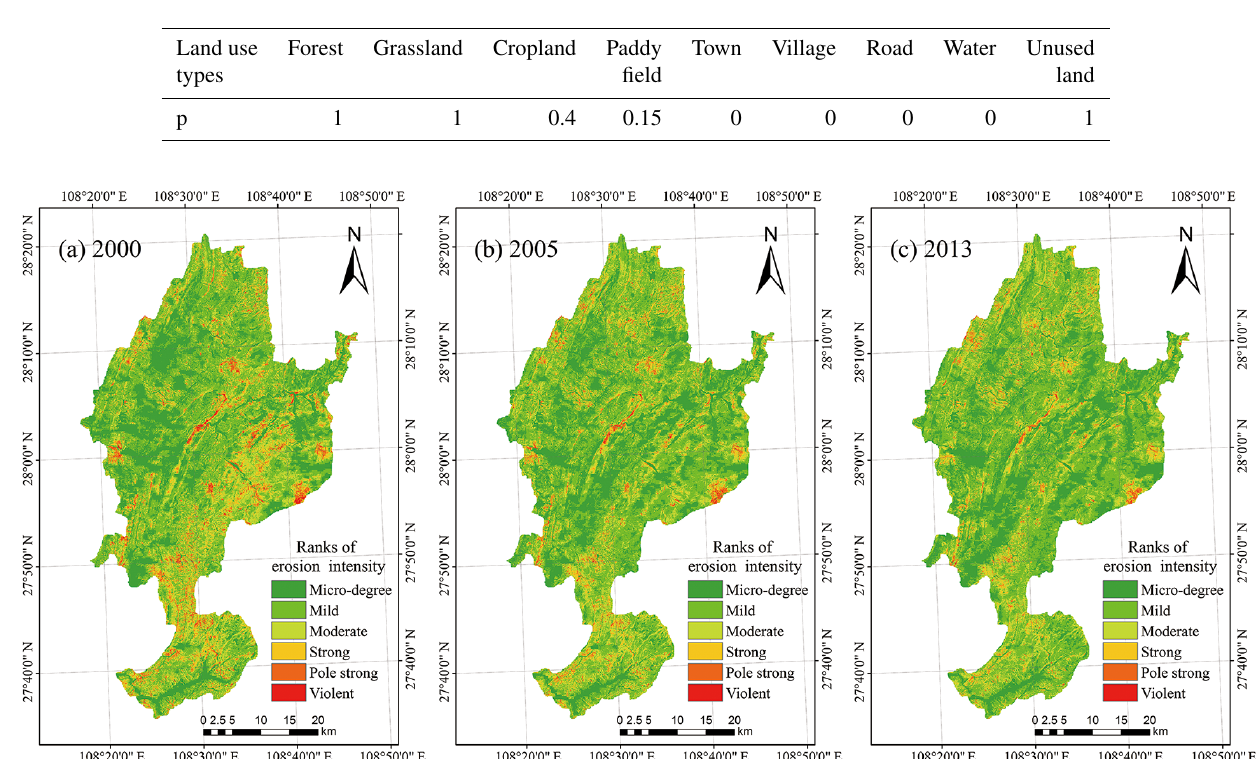
Figure 4. Spatial distribution of soil erosion in Yinjiang in different